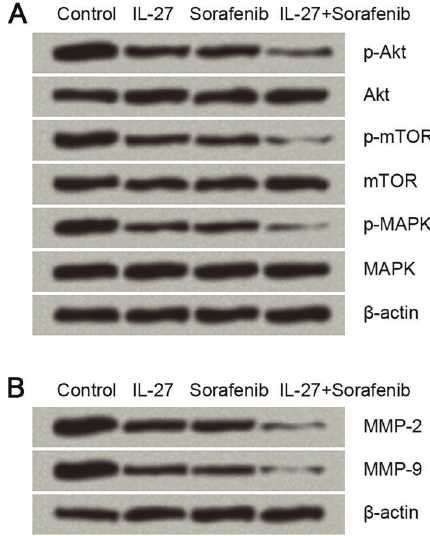
Figure 6. Effect of IL-27 (50 ng/mL) and sorafenib (2 m M) alone or in combination on Akt/mTOR/MAPK signaling pathway on HTB-9 cells. Cells cultured with blank medium acted as control. Protein expression was assessed by western blot analysis. A , Expression of key kinases involved in the Akt/mTOR/MAPK pathway, and B , of downstream proteins involved in the pathway. IL-27: interleukin 27; mTOR: mechanistic target of rapamycin; MAPK: mitogen- activated protein kinase; MMP: matrix Figure 6A, p-Akt, p-mTOR and p-MAPK were all down- regulated by single simulation of IL-27 or sorafenib, and the down-regulations were further enhanced by the com- bined treatment. Moreover, the downstream MMP-2 and in Akt/mTOR/MAPK pathway (Figure 6B). Therefore, we